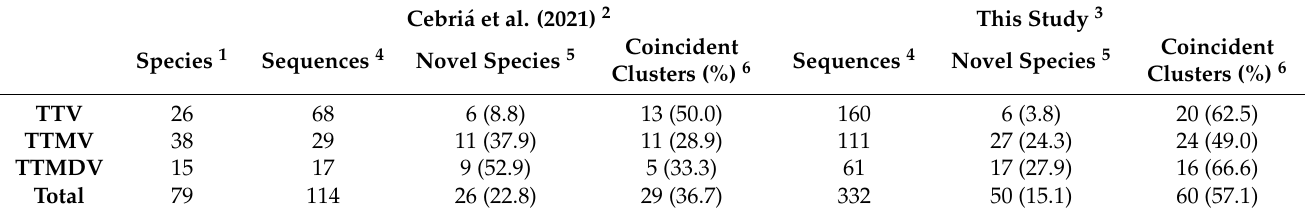
Table 2. Summary of anellovirus analysis. 1 Number of reference species currently accepted by ICTV for each genus. 2 Results obtained after reevaluating data from our previous study [18] using the currently accepted species and the recently proposed species demarcation criterion by the ICTV. 3 Results obtained analyzing the newly described sequences. 4 Genus assignment for the described sequences. 5 Number of new species (percentage with respect to the total number of described sequences for each genus is given between brackets). 6 Number of species that cluster with at least one new sequence (percentage with respect to the total number of species is given between brackets). Novel species identified from our previous study were also used as reference species on subsequent phylogenetic and pairwise identity